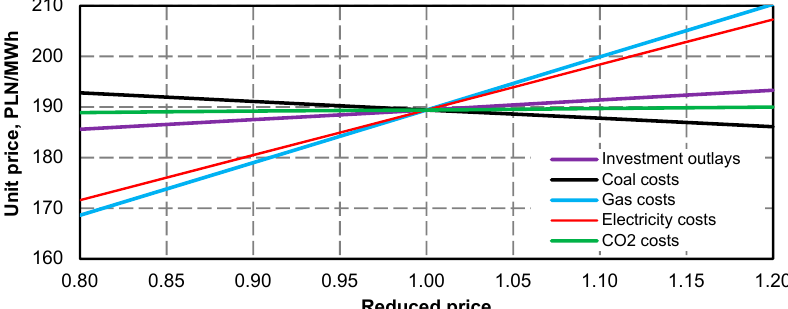
Figure 52. The impact of investment outlays, gas cost, unit cost of power generation before the upgrade, the cost of CO 2 emission permits on the unit cost of electric power generation in the upgraded power unit for operating the gas turbine at a variable power and with a single-pressure recovery boiler.